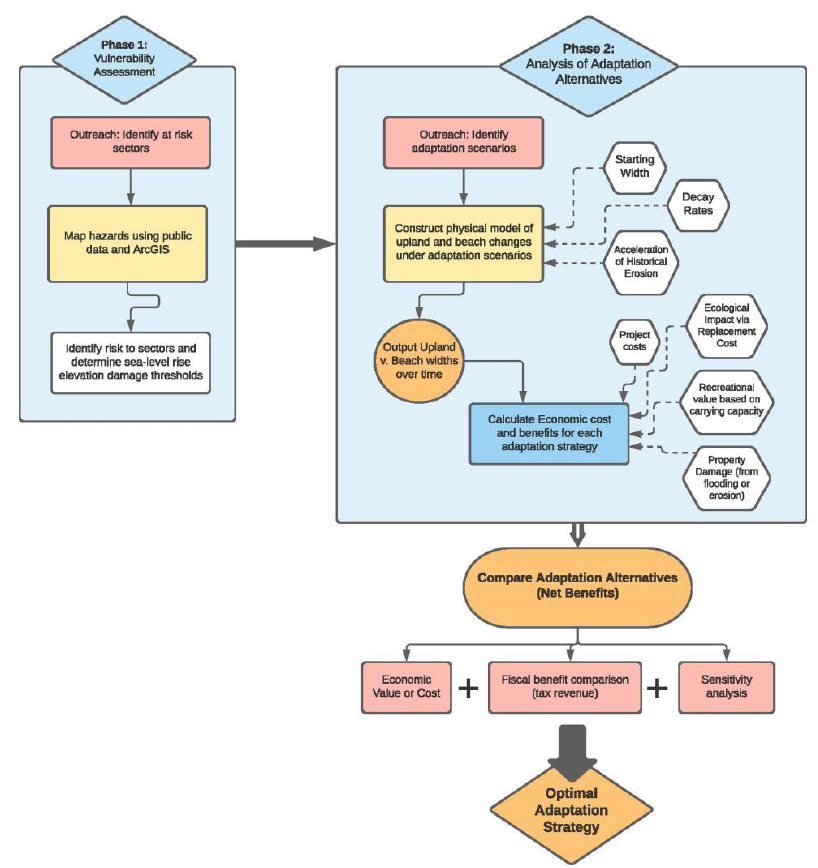
Figure 1. Adaptation framework process including Phase One (Vulnerability Assessment) and Phase Two (Analysis of Adaptation